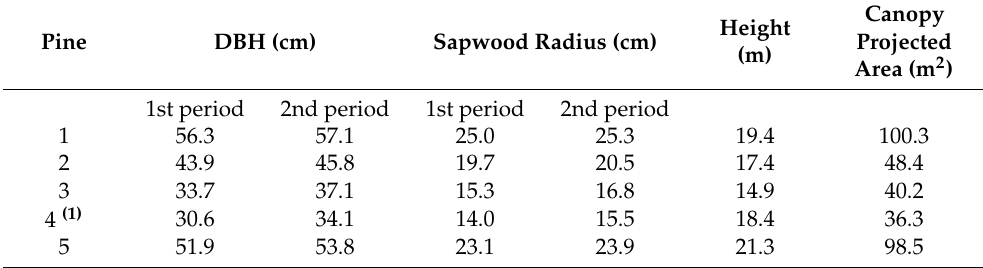
Table 1. Biometric traits of the monitored Aleppo pine trees.